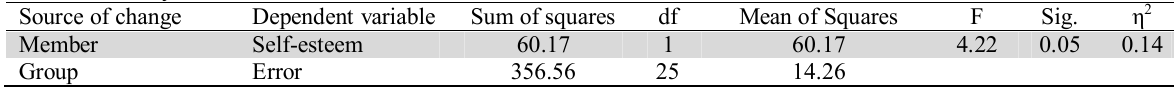
The summary of ANOVA test Source of